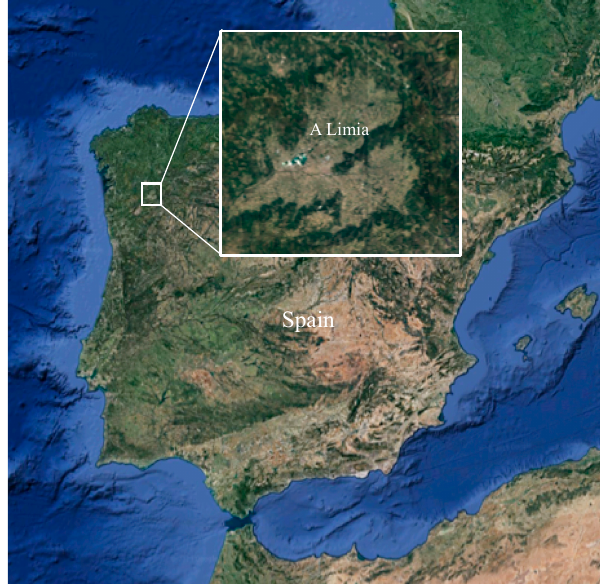
Figure 1. Location of the study area.